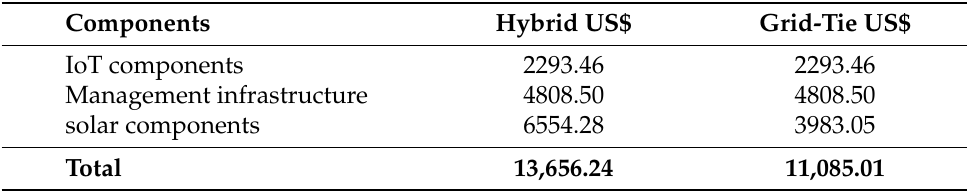
Table 5. Equipment cost.